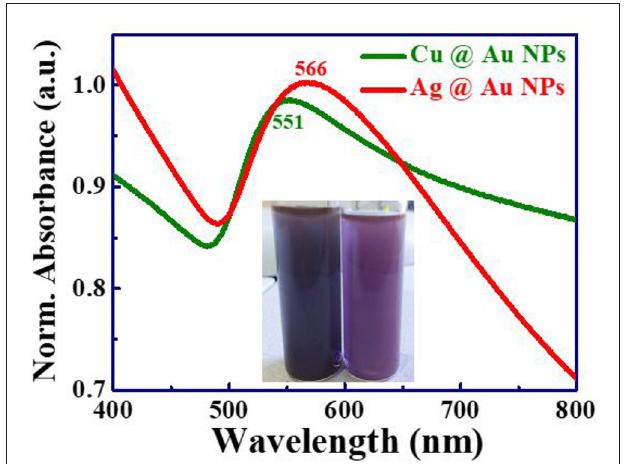
FIGURE 1 | UV-Visible absorption spectra of Ag@Au NPs with SPR peak at 566nm (red, top) and Cu@Au NPs with SPR peak at 551nm (green, bottom) prepared in HAuCl 4 5mM solution (a.u. stands for arbitrary units).